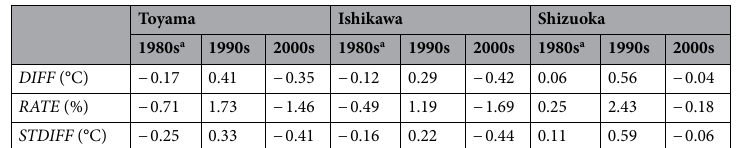
Table 1. Ten-year difference ( DIFF ) in and rate of change ( RATE ) of the 90th percentile values of daily mean temperature during July–August ( TEMP ) during each decade and standardized difference ( STDIFF ) of the annual TEMP during 3 decades in the three prefectures. a From 1983 to